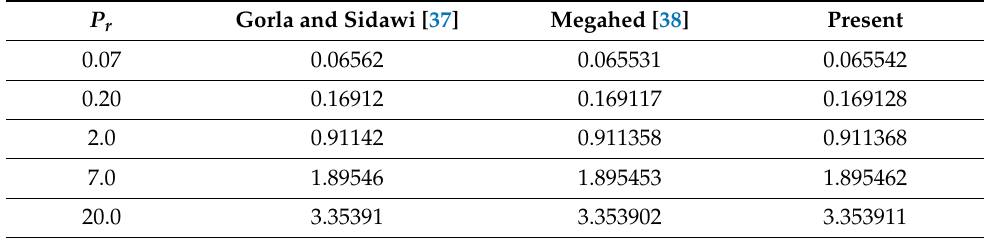
(cid:16) (cid:17) NuRe − 1/2 for various values of Pr when λ T = λ C =